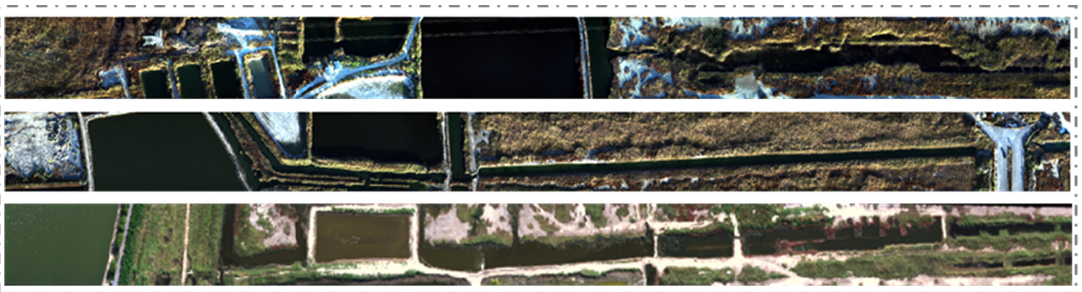
Figure 2. UAV flight data in the study area, according to the R, G, B band, the corresponding bands are the 77th, 50th, and 26th bands, and the wavelengths are 642, 551, and 472 nm, respectively.